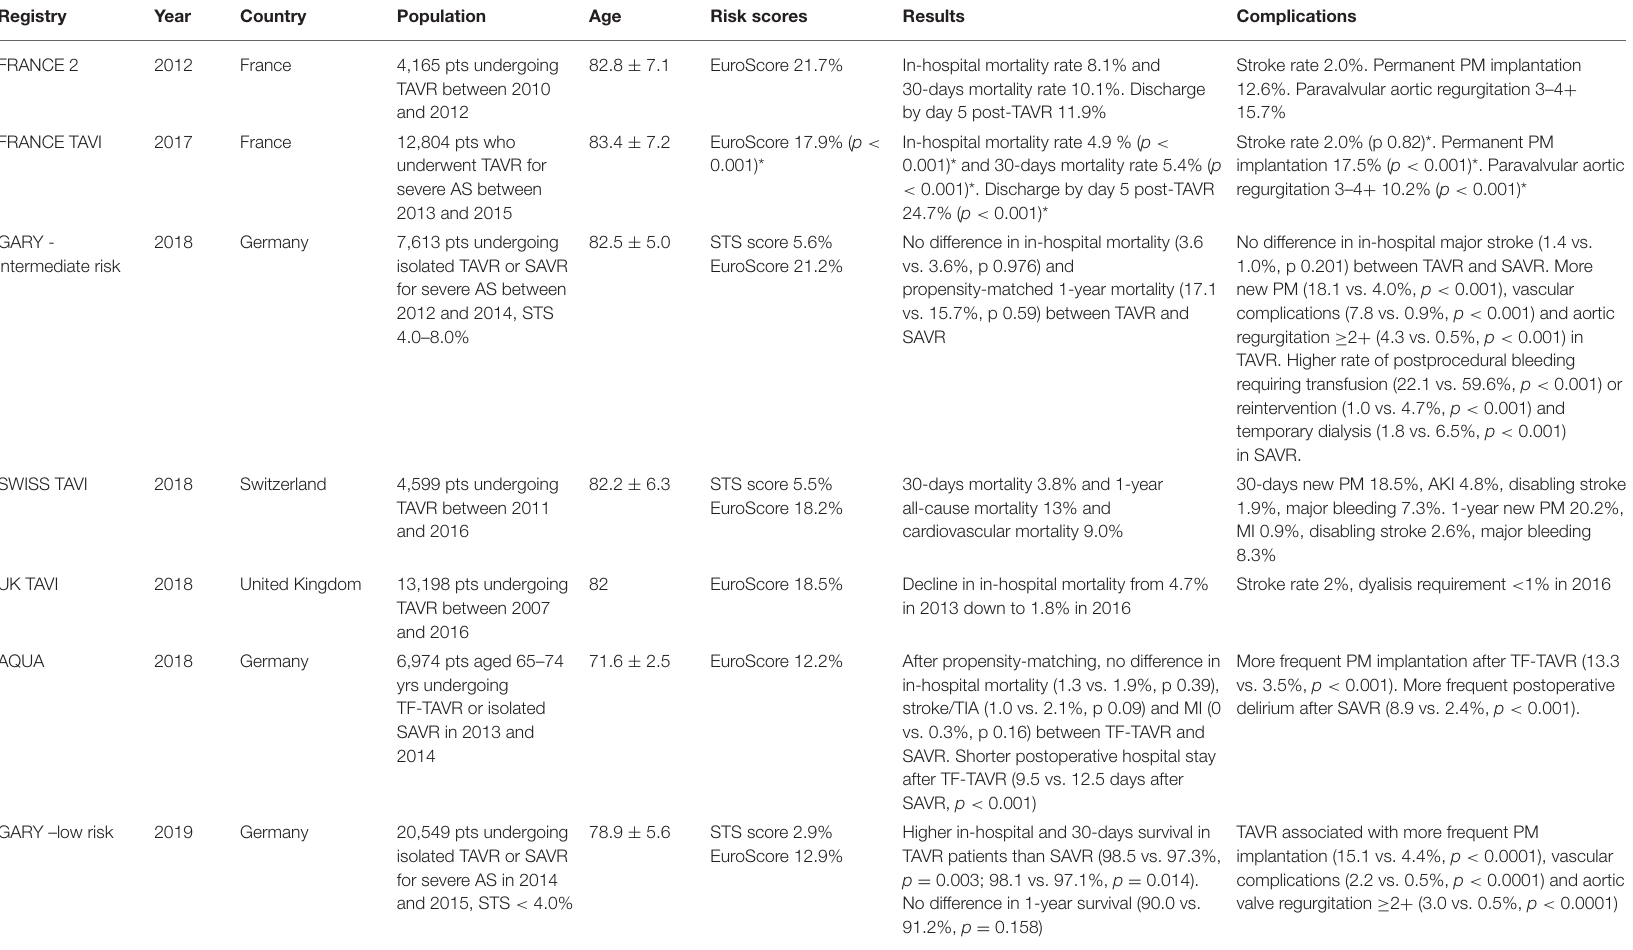
TABLE 2 | Characteristics of the published registries on transcatheter aortic valve replacement.